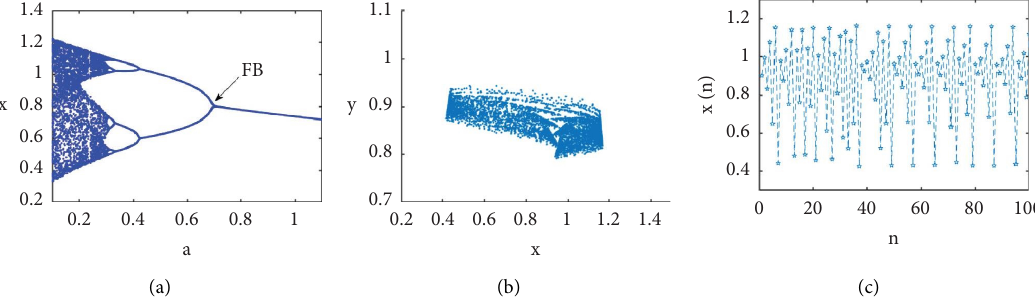
Figure 3: (a) Bifurcation diagram of model (4) in ( a,x ) plane. (b) Chaotic attractor for a � 0 . 2 in (a). (c) Time sequence diagram of prey densities in (b).